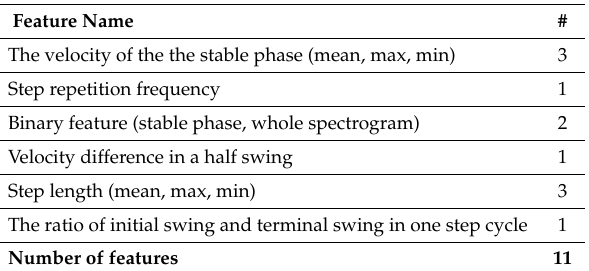
Figure 10. ( a ) The spectrogram of walking in stable phase ( b ) binary figure converted from the spectrogram. Table 2. List of the features extracted for gait